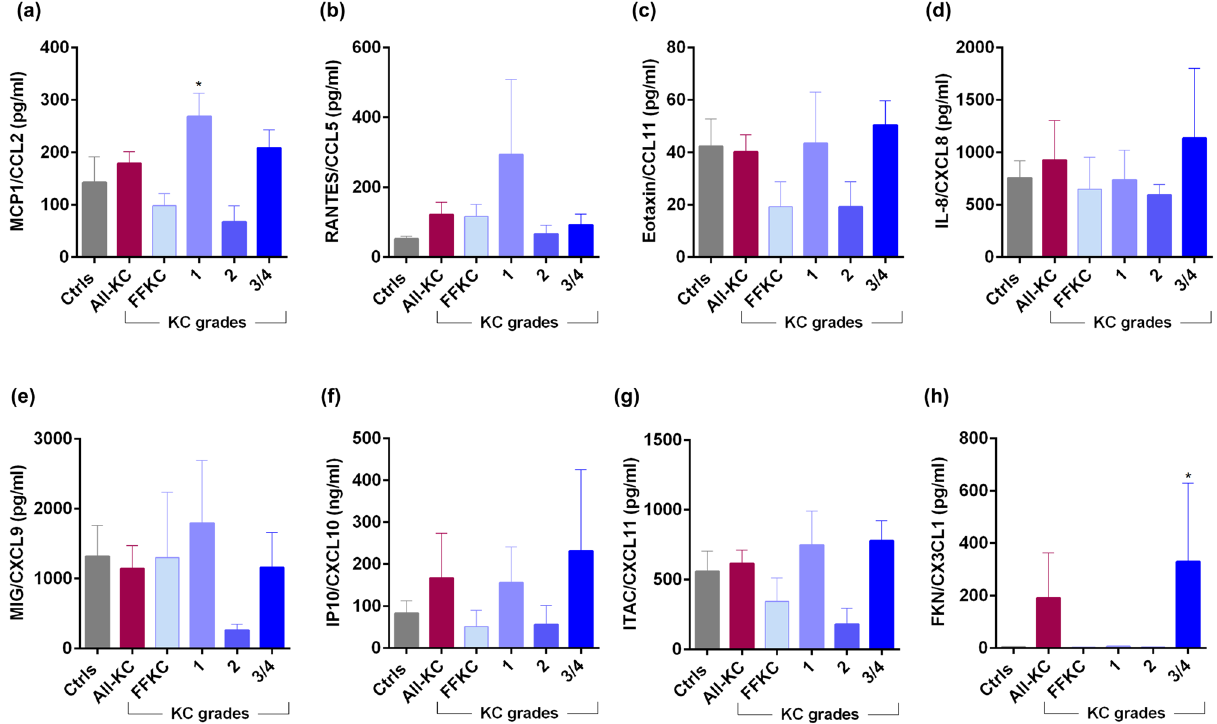
Figure 4. Tear fluid chemokines level in KC patients: The graphs indicate the concentration of MCP1/CCL2 ( a ), RANTES/CCL5 ( b ), Eotaxin/CCL11 ( c ), IL-8/CXCL8 ( d ), MIG/CXCL9 ( e ), IP10/CXCL10 ( f ), ITAC/ CXCL11 ( g ) and FKN/CX3CL1 ( h ) in the tear fluid of subjects with different grades of KC. Ctrls—Controls; All-KC—all the grades of keratoconus combined; FFKC—Forme fruste keratoconus; FKN—fractalkine; IL— interleukin; MCP1—monocyte chemoattractant protein 1; MIG—monokine induced by gamma interferon; IP-10—Interferon gamma-induced protein 10; ITAC—Interferon-inducible T-cell alpha chemoattractant; RANTES—Regulated upon Activation, Normal T Cell Expressed and Presumably Secreted; SEM—standard error of the mean; Controls (20 eyes), All-KC (41 eyes), FFKC (6 eyes), grade 1 KC (6 eyes), grade 2 KC (6 eyes), grade 3 or 4 (23 eyes); Bar graphs represent Mean ± SEM; *P < 0.05, Mann–Whitney